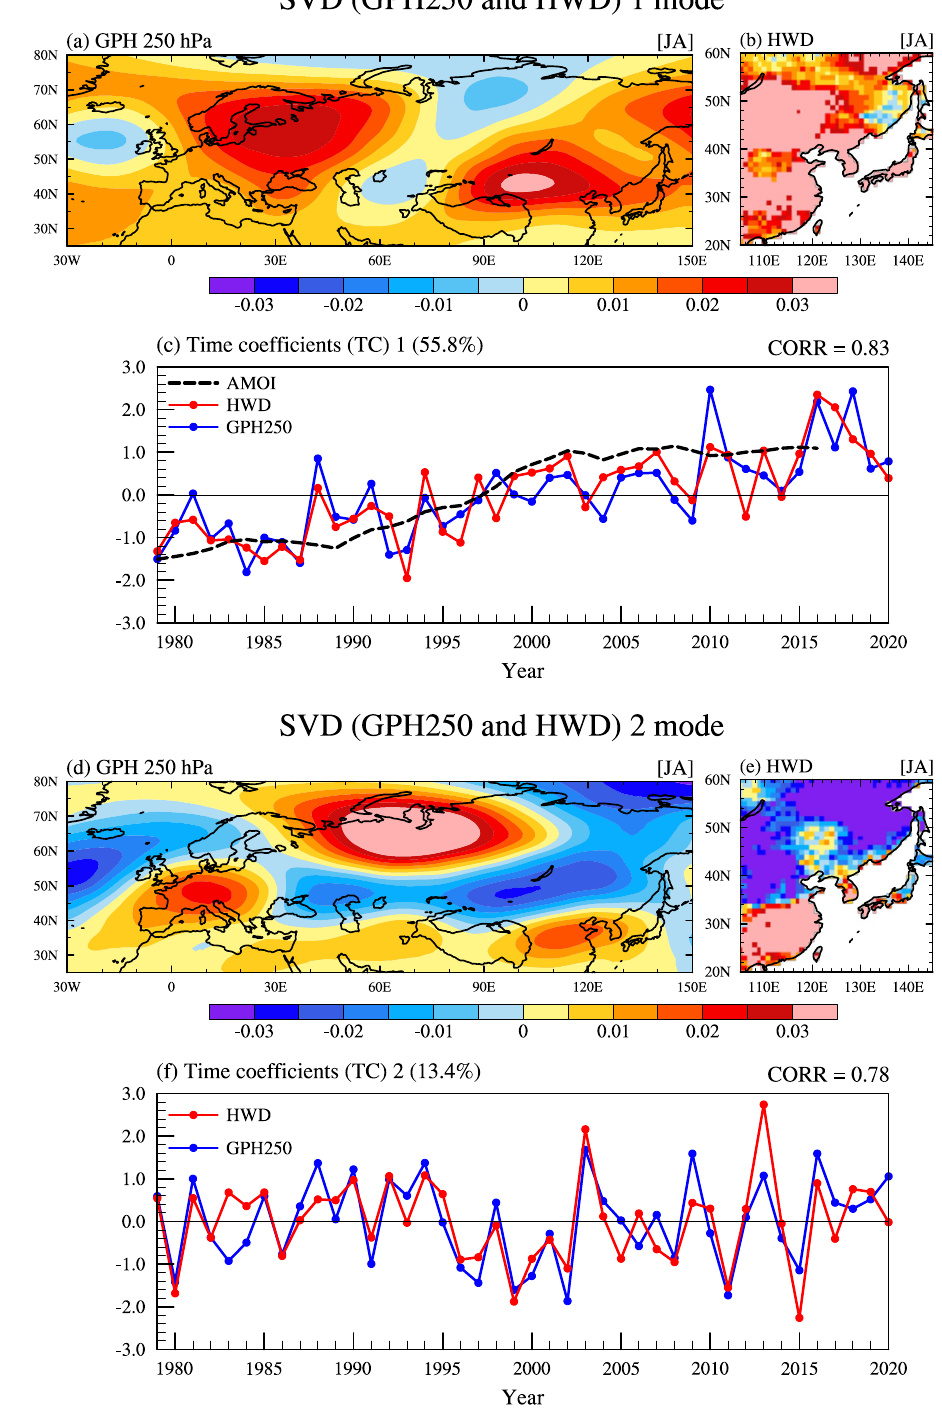
Figure 2. SVD mode 1 and mode 2 of geopotential height at 250 hPa (GPH250) and heatwave days (HWD). ( a )–( c ) First and ( d )–( f ) second coupled modes of SVD. From July to August, the coupled patterns of ( a and d ) GPH250 and ( b and e ) HWD in East Asia. ( c and f ) The standardized time series of the SVD time coefficients (TC) for GPH250 (blue line) and HWD (red line). The black dashed line in ( c ) indicates the AMO